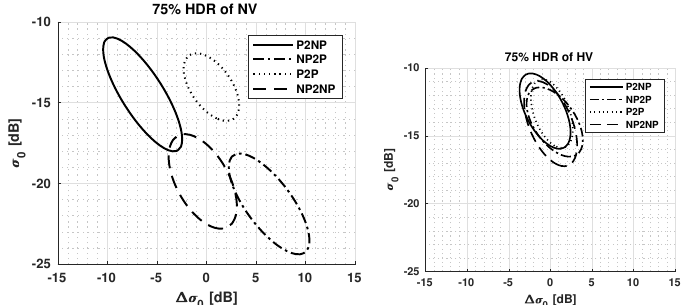
Figure 4. The 75% Highest Density Region (HDR) plots for NV and HV for all precipitation condition